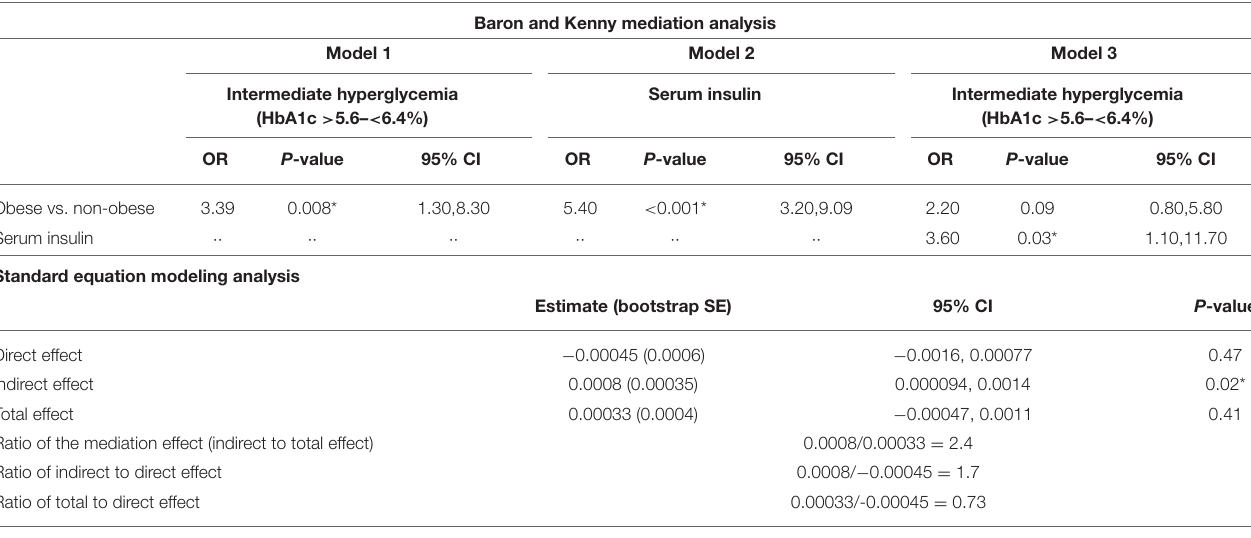
TABLE 7 | Mediation effect of insulin on the association between BMI and intermediate hyperglycemia adhering to the principles of Baron and Kenny and by using the standard equation modeling analysis, adjusted for age and